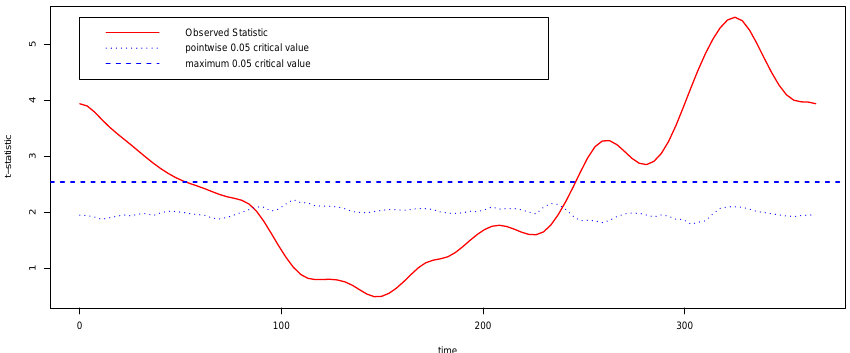
Figure 5. A t-test based on permutations for the temperature data of Atlantic and Continental zones. The dashed line gives a critical value for the maximum of the t-statistic and the dotted line provides the permutation critical value for the pointwise